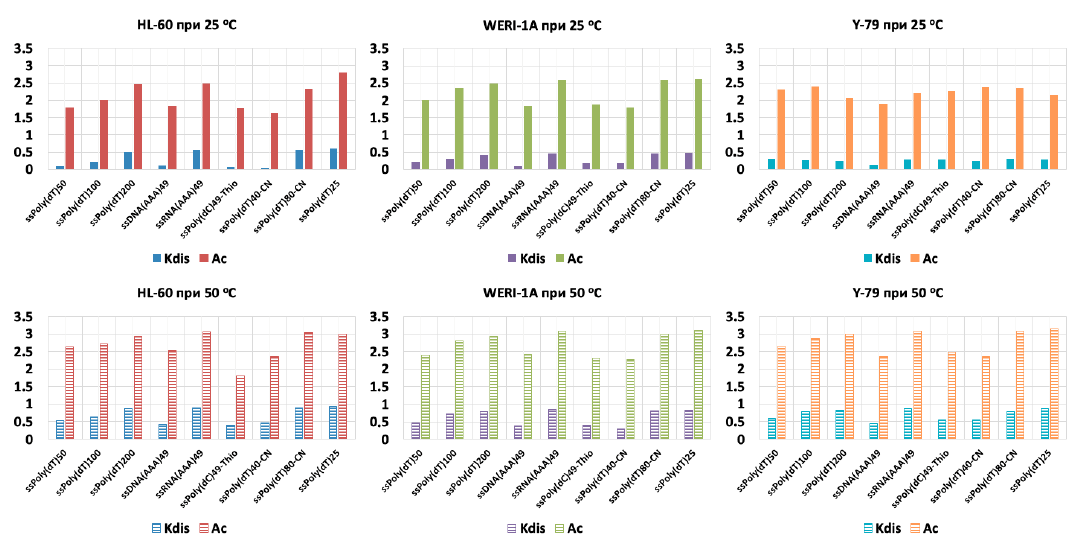
Figure 5. Polynucleotide–enzyme binding patterns ( K dis , A c ) estimated for beta-like DNA polymerase species from three cancer cell lines (HL-60, WERI-1A, Y-79). For technical details, see Methods.